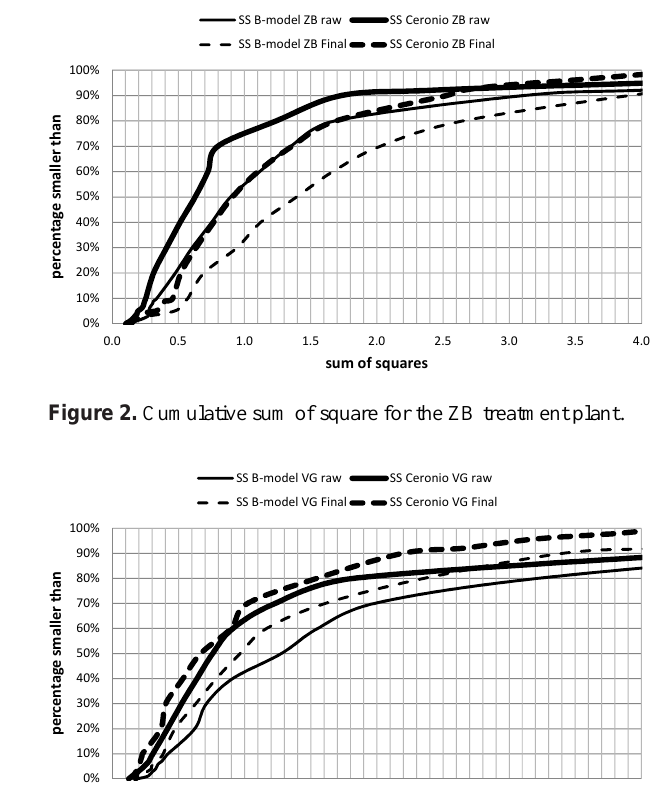
4 Discussion of the Ceronio